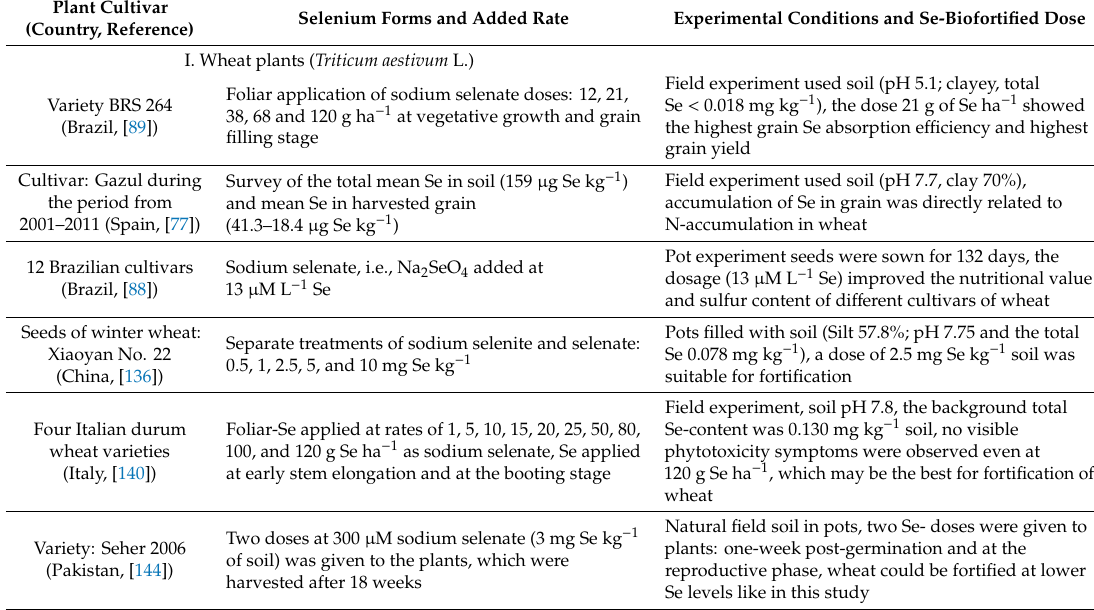
Table 2. Selenium biofortification results of some selected cereal crops (wheat, rice, and maize) under di ff erent growth